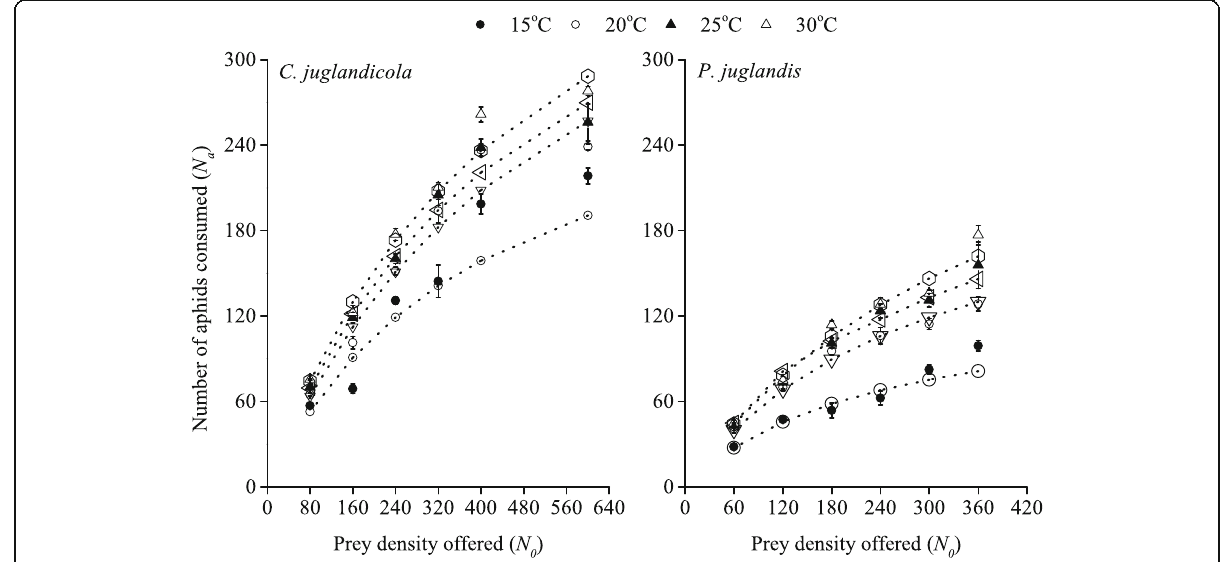
Fig. 1 Functional response fitting curve of H. axyridis to C. juglandicola and P. juglandis under four different temperature